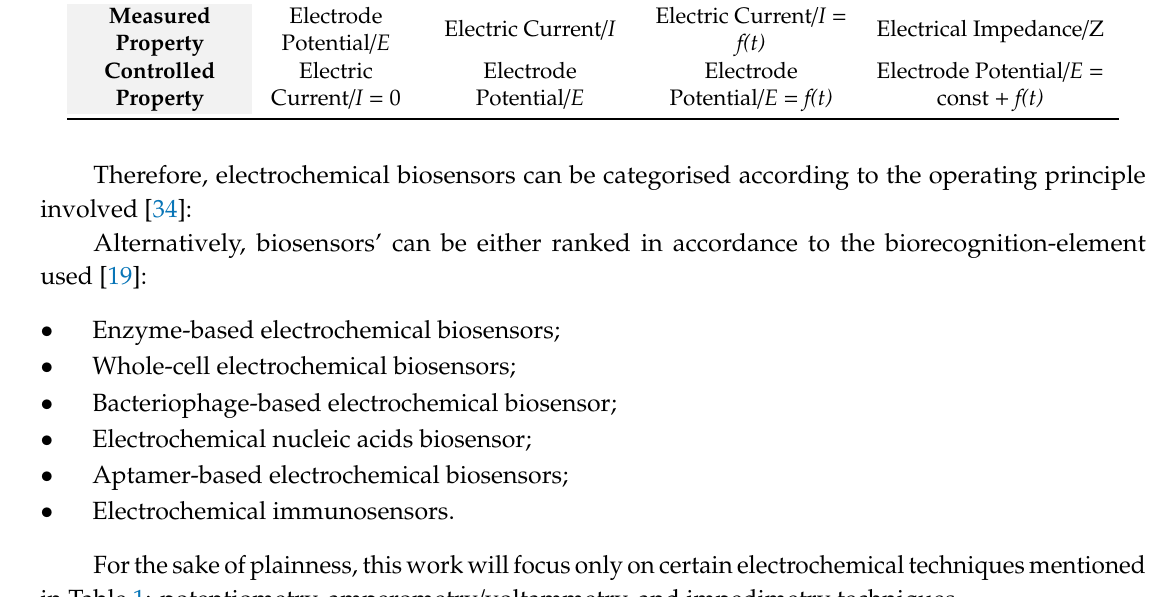
Table 1. Interfacial electrochemical techniques employed in electrochemical biosensor devices. Method Potentiometry Amperometry Voltammetry Impedimetry Measured Electrode Electric Current / I = Electric Current / I Electrical Impedance / Z f(t) Property Potential / E Controlled Electric Electrode Property Current / I = 0 Potential /